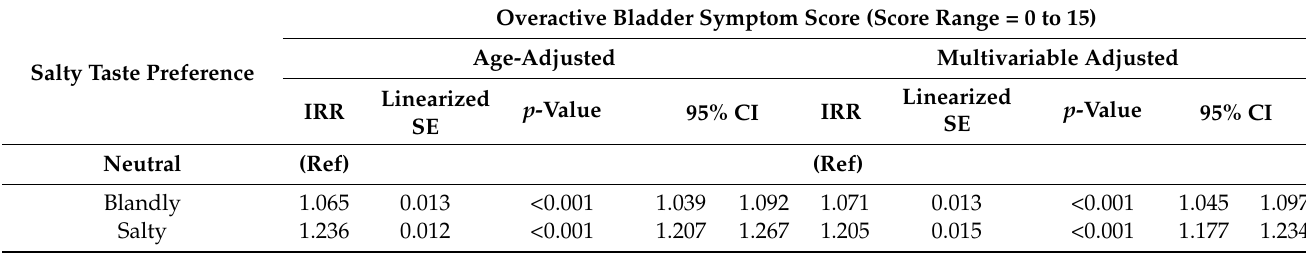
Table 2. Impact of salty taste preference on overactive bladder symptom among South Korean female adults. Overactive Bladder Symptom Score (Score Range = 0 to 15) Age-Adjusted Multivariable Salty Taste Preference